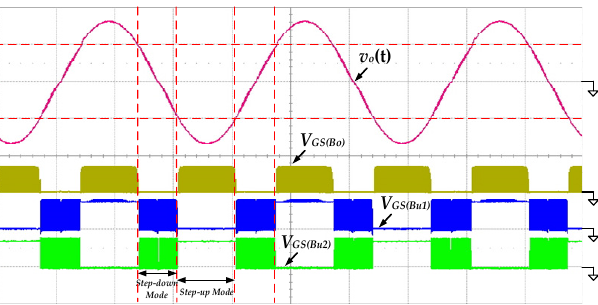
Figure 15. The measured waveforms of the gate-driving signals at 200 V input voltage and 500 W output load ( v o ( t ): 200 V/div; V GS ( Bo ) , V GS ( Bu 1) , V GS ( Bu 2) : 20 V/div; time: 5 ms/div). Figure 16 presents the measured waveforms of the currents and the voltages of the coupled inductor. As shown in Figure 16a, the coupled inductor is still used as a filter in step-down mode, and the inductor voltages are almost zero. The waveforms are zoomed-in at the peak of the output voltage v o ( t ) and shown in Figure 13b. Due to the higher input voltage, the duty ratio of the switch S Bo is reduced, and the charging time of the primary inductor is shorter. During the switch S Bo turning off, the inductor currents i LP and i LS are still the same, proving that the primary and secondary inductors are discharging in series to increase voltage gain.